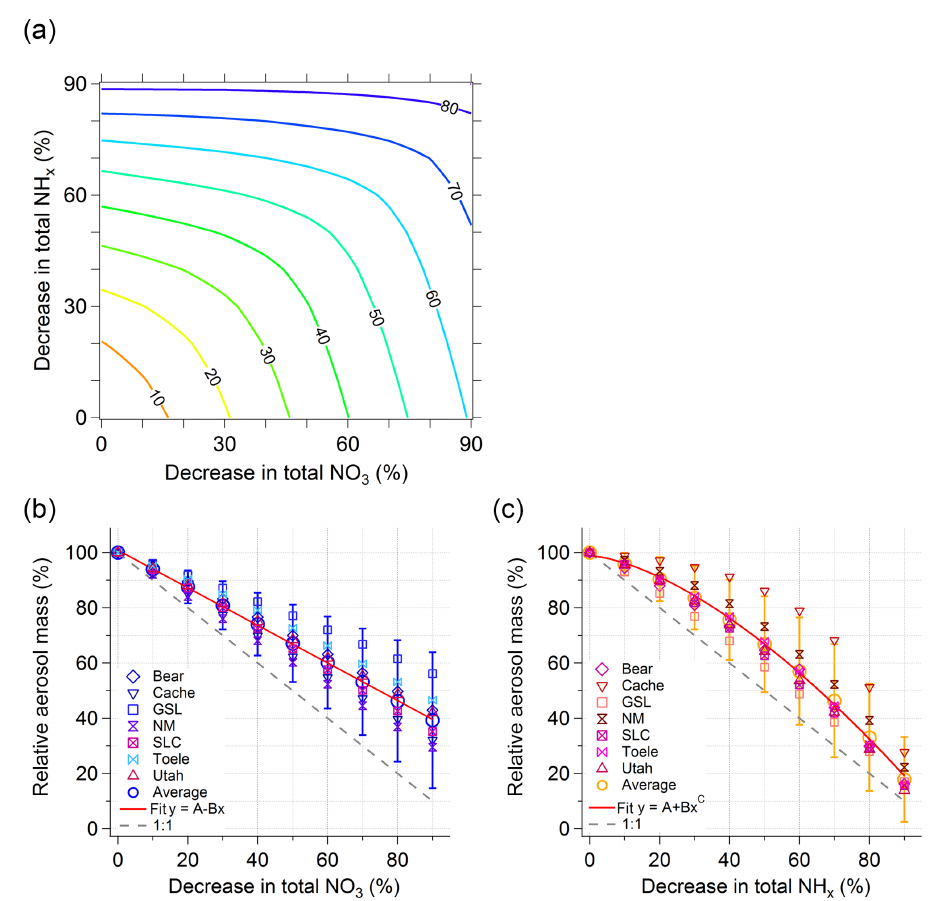
Figure 11. (a) Contour plot showing the simulated decrease in total inorganic aerosol mass (contour lines, numbers shown in %) as a function of decrease in both total nitrate ( x axis) and total ammonium ( y axis). The data inputs used here are from the entire region. The decreases are relative to the observed conditions and expressed as percentages. Panels (b) and (c) show one-dimensional views of the surface plot shown in panel (a) . Panels (b) and (c) are projections along the x and y axes, respectively. Panel (b) shows the simulated decrease in total inorganic NR-PM 1 as a function of the decrease in total nitrate. In these simulations, the concentrations of total ammonium were kept constant and equal to the observed conditions. Panel (c) shows the simulated decrease in total inorganic NR-PM 1 as a function of the decrease in total ammonium. In these simulations, the concentrations of total nitrate were kept constant and equal to the observed conditions. The open circles are averages over the entire region (same as panel a ). The error bars are the standard deviations associated with the averages. The other markers are data relative to particular regions: Bear Valley, Cache Valley, the Great Salt Lake, North Metro, Salt Lake Valley, Tooele Valley, and Utah Valley. The dashed grey line is the 1 : 1 line and the red solid lines are a fit through the average points to guide the eye (linear fit in panel b and power law in panel c